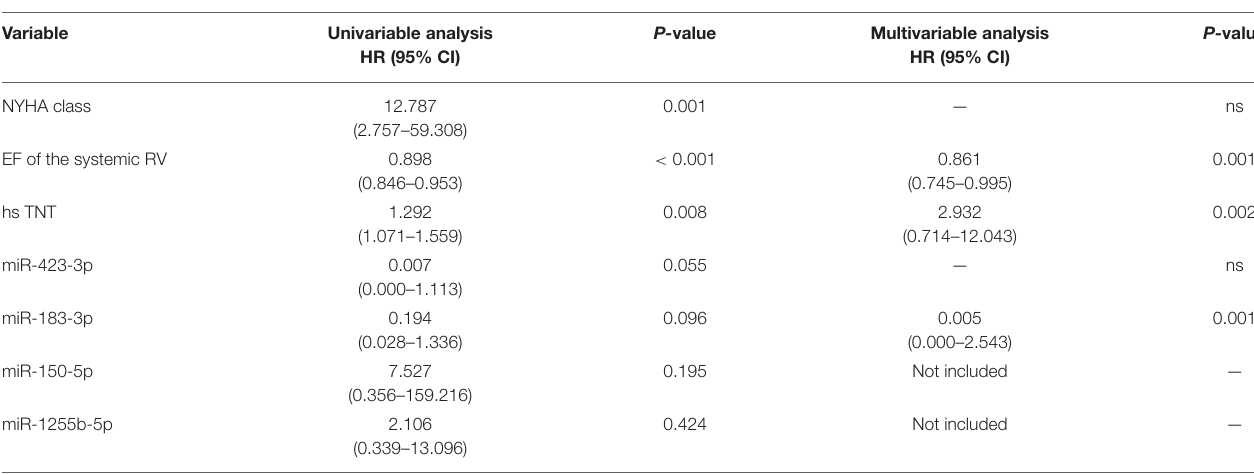
TABLE 4 | Predictors of worsening HF (Cox regression